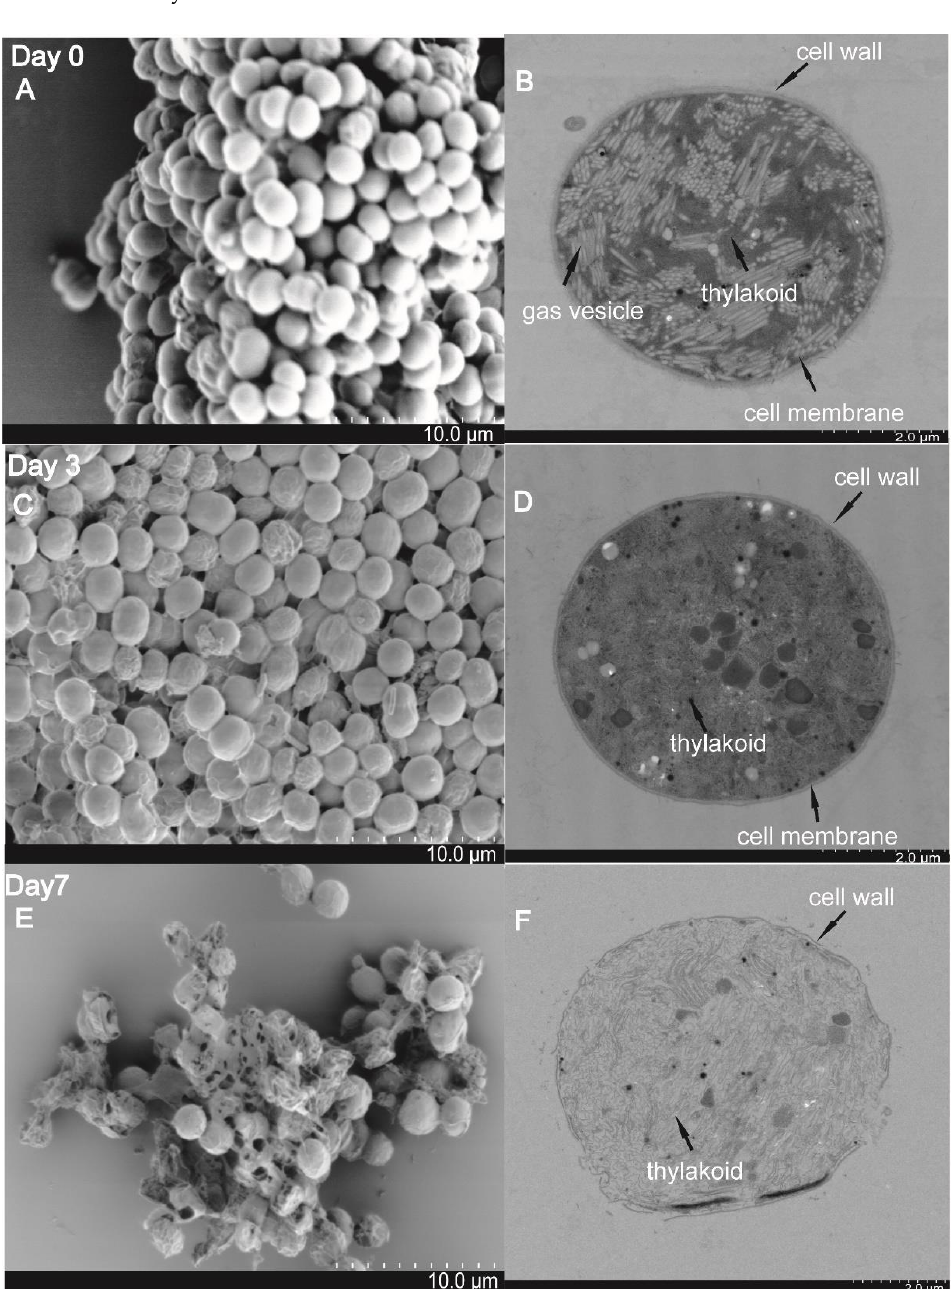
Figure 4. Cell morphology and ultrastructures of M. aeruginosa PCC 7806 visualized by scanning electron microscopy (SEM) and transmission electric microscopy (TEM) after treatment with SJ-73 filtrates for 0 days ( A , B ), 3 days ( C , D ), and 7 days ( E , F ).